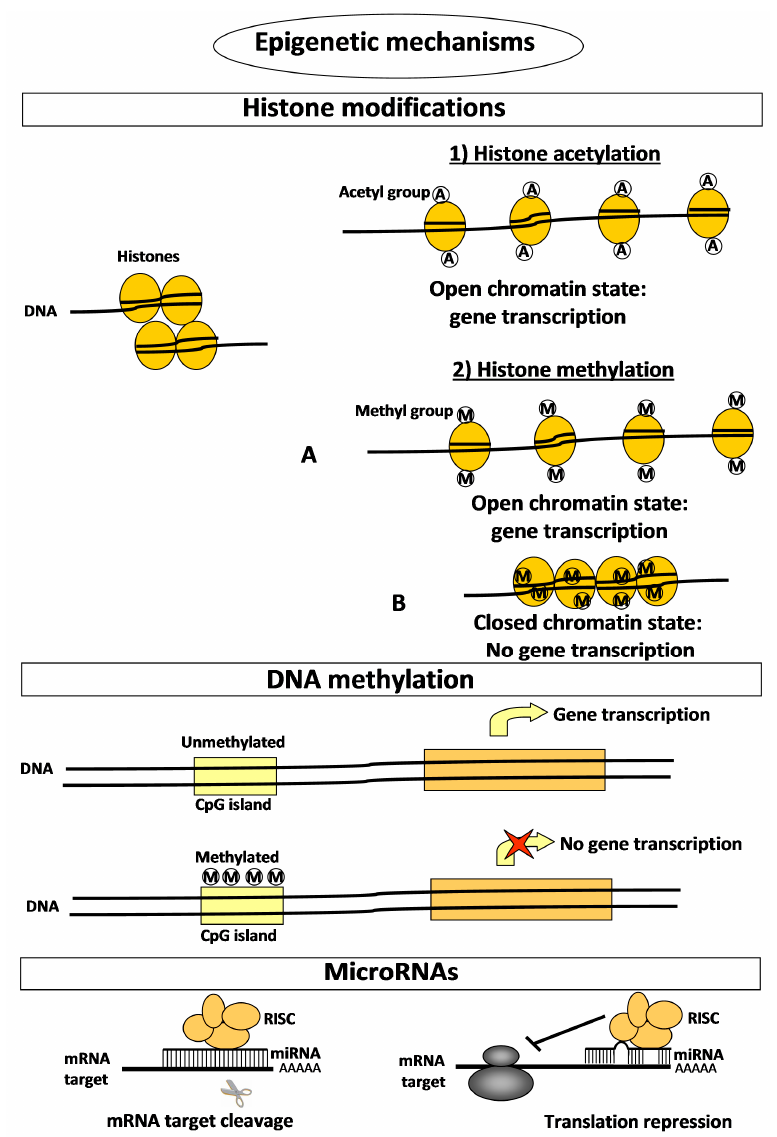
Figure 1. Schematic representation of the mechanism of action of epigenetic mechanisms. Histone acetylation positively regulates gene expression by inducing the opening of chromatin conformation and, thus, favouring the binding of transcription machinery. Histone methylation promotes the opening (panel A ) or closing (panel B ) of the chromatin conformation depending not only on the specific lysine residue modified, but also on its degree of methylation (Table 1). In this way, histone methylation can specifically induce or repress gene expression. MicroRNAs (miRNAs) suppress gene expression by selectively binding to the 3 ′ non coding region (3 ′ UTR) of their mRNA targets through base-pairing. miRNAs can negatively regulate gene expression by two different post-transcriptional mechanisms: the cleavage of the mRNA target or the physical blocking of translation machinery. The choice of mechanism of action is determined only by the nucleotide complementarity between the miRNA and its mRNA target: the miRNA will cleave the target when it has sufficient complementarity to the miRNA itself, or it will repress translation, by physically blocking ribosome activity, if the mRNA does not have sufficient complementarity. In the first case, after the cleavage the miRNA remains intact and active and can proceed to the cleavage of other mRNA targets.